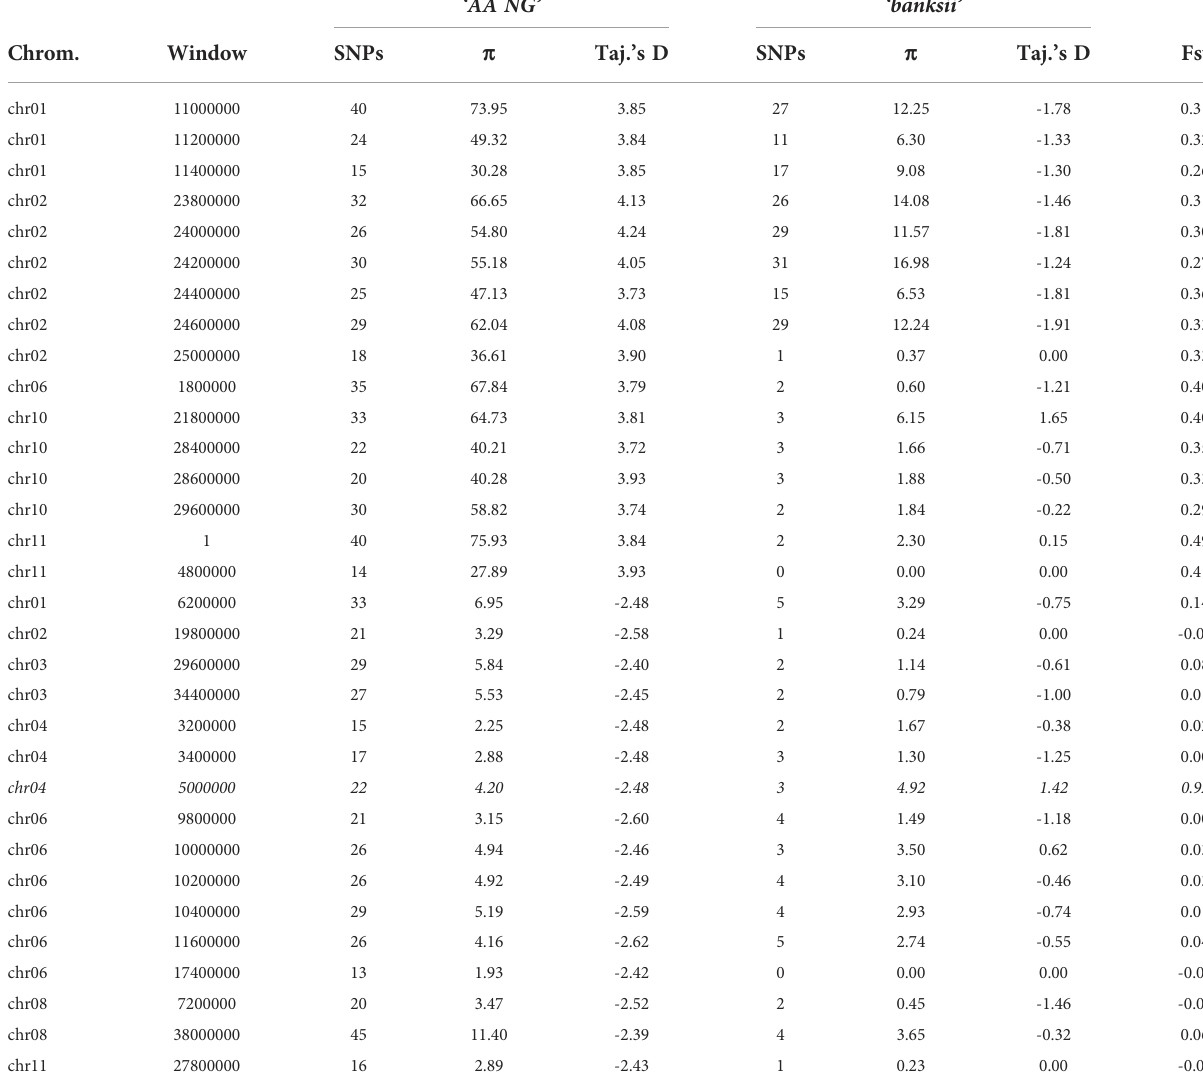
TABLE 3 Number of SNPs, Pi ( p ) and Fst between the clusters ‘ banksii ’ and ‘ AA NG ’ for the windows (200 kb) with the 1% lowest and 1% highest values of Tajima ’ s D calculated for ‘ AA NG ’ .